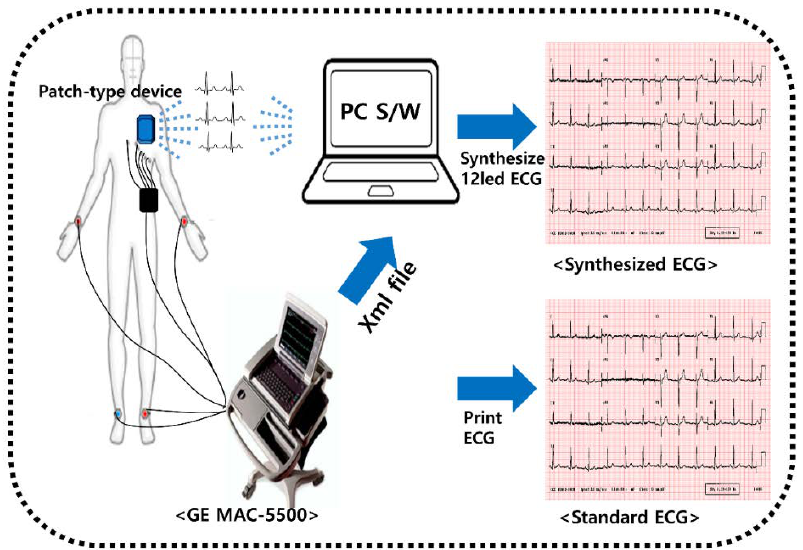
Figure 3. System for the clinical validation of a reconstructed ECG from a patch-type device. ECG: electrocardiogram.